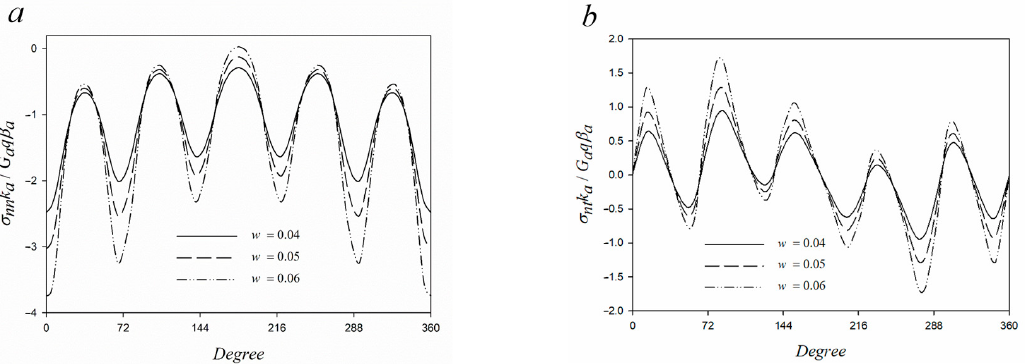
Figure 11. Interfacial ( a ) normal and ( b ) shear stress of a coated pentagonal hole ( G b / G a = 3 , β b / β b = 3 ,